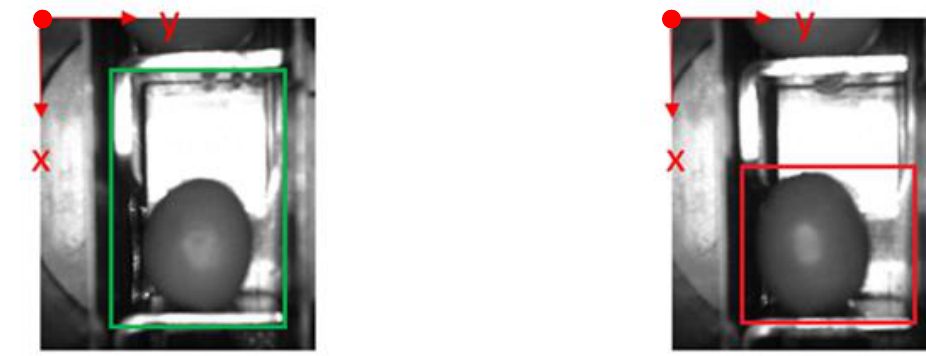
Figure 2. Example of the use of ROI in an olive in a “boat” position between [80 ◦ , 90 ◦ ] and [ − 80 ◦ , − 90 ◦ ].